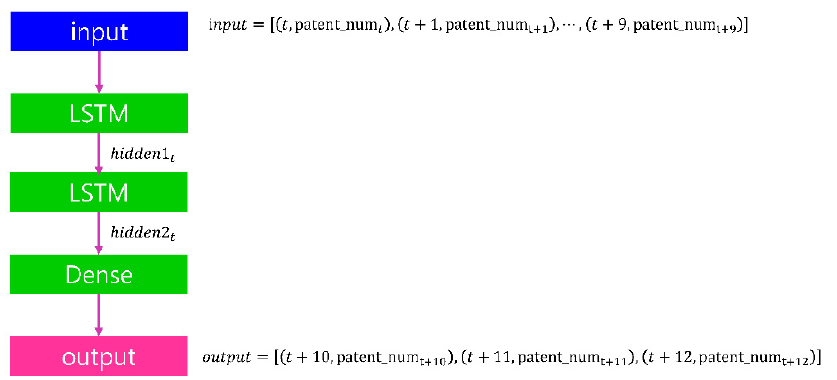
Figure 2. Architecture of stacked long short-term memory (LSTM): patent_num t is replaced by paper_num t for SCI paper analysis. Table 3. Rate of increase and prediction accuracy of the predicted number of patents by